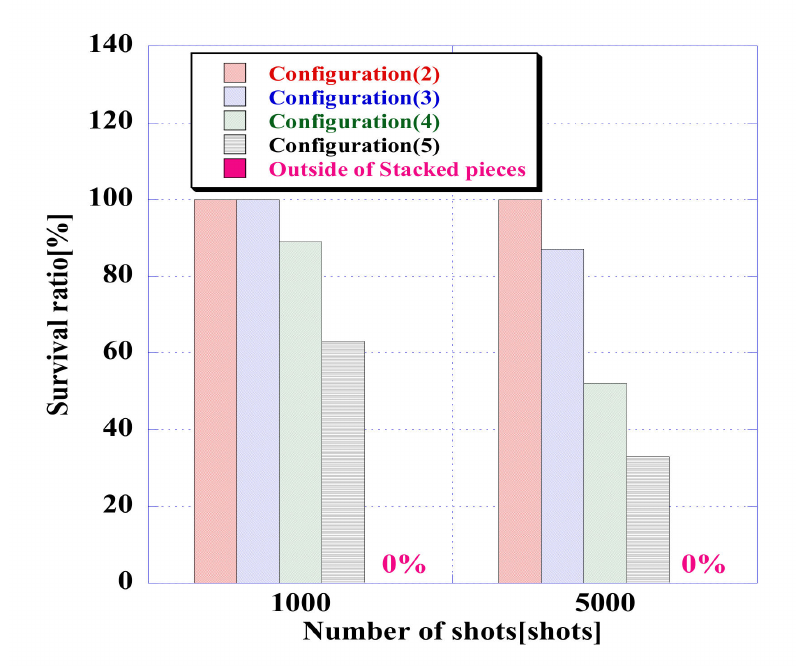
Figure 10. Survival ratios of E. coli in each configuration after applying each pulse number.